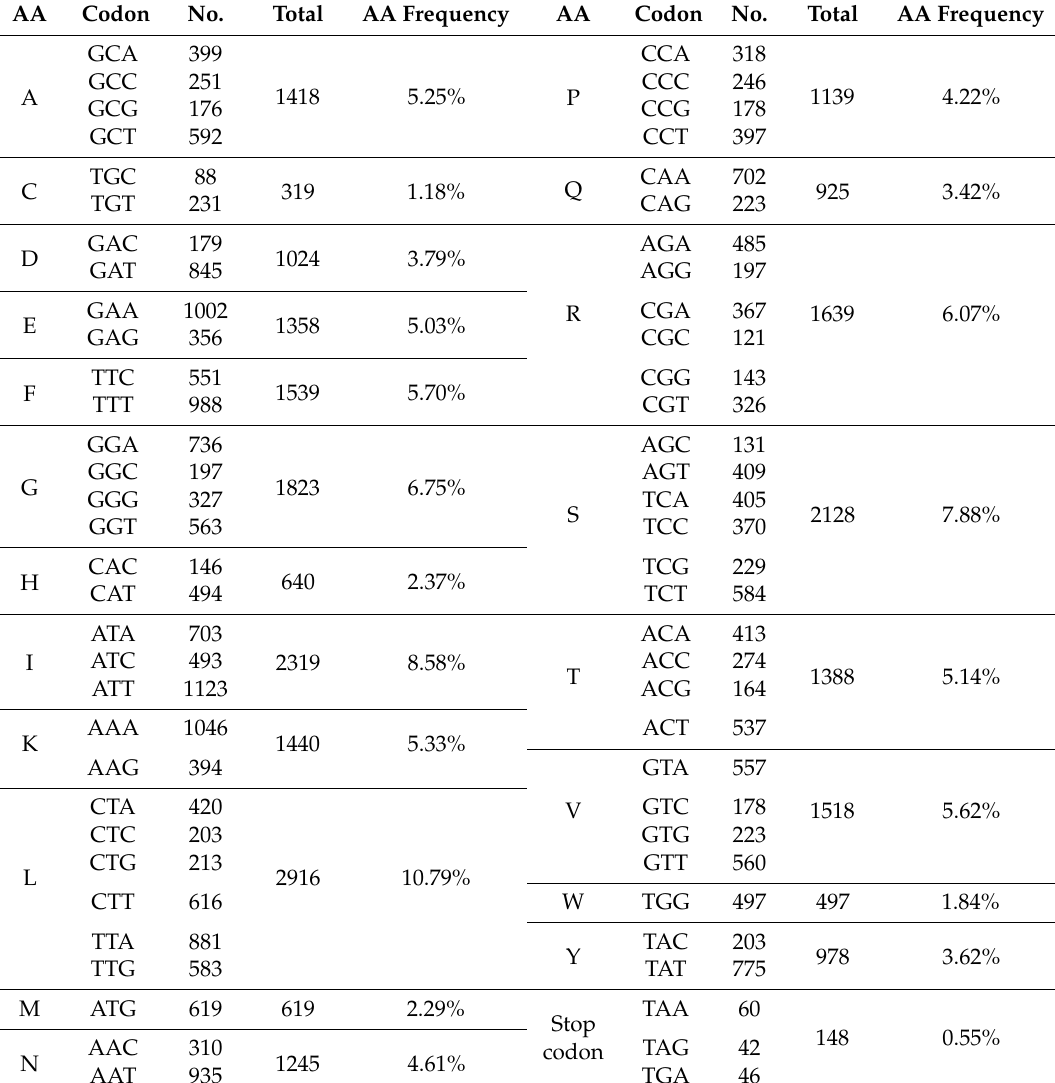
Table 2. Codon usage of P. cablin chloroplast